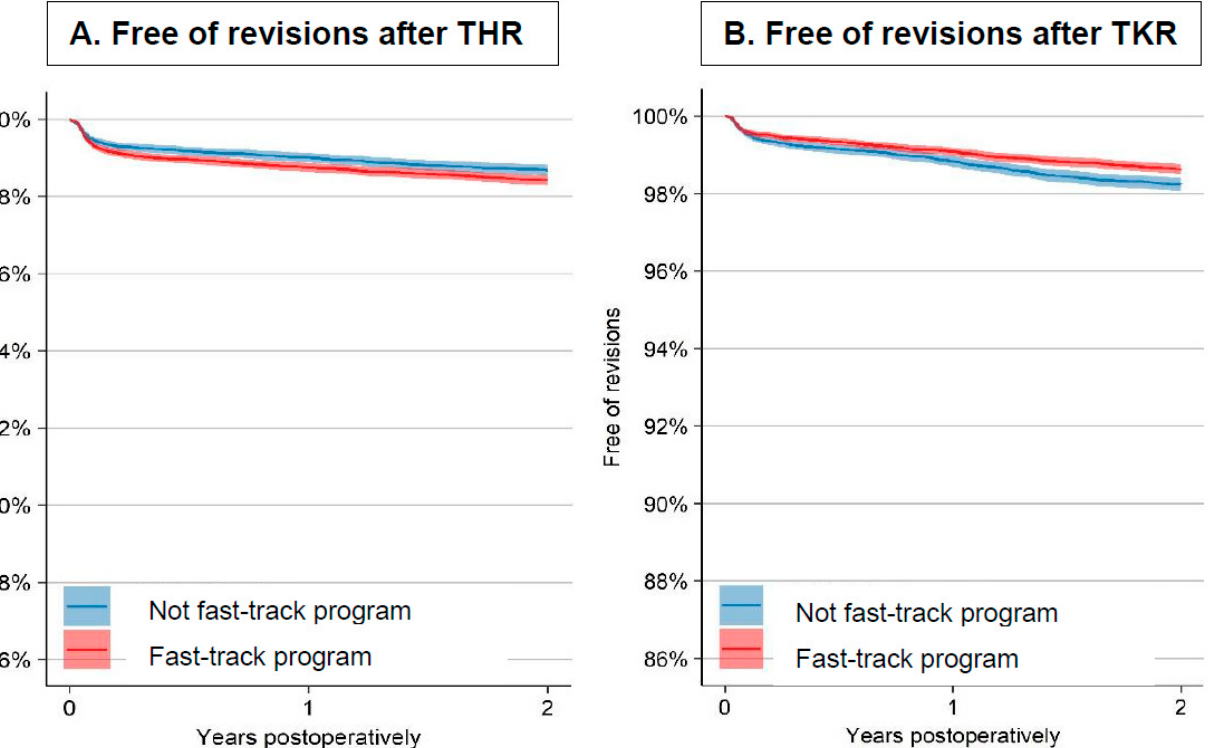
Figure 3. Hazard ratio (95% CI) for revisions and mortality within 2 years in fast-track programs of THR and TKR with non-fast-track as reference. HR: hazard ratio; CI: confidence interval.